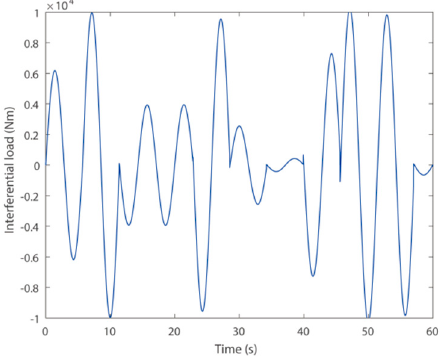
Figure 5. The interferential load curve.